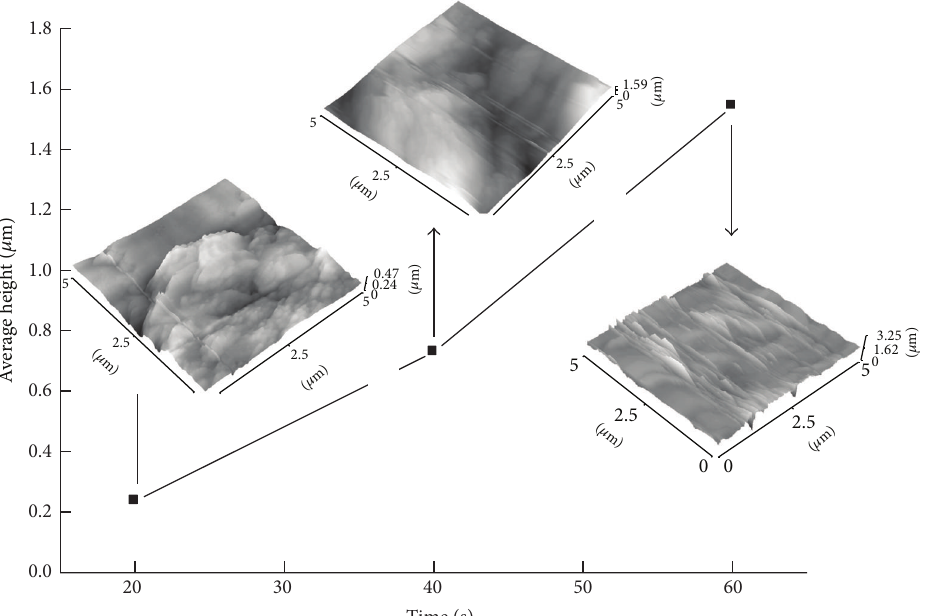
Figure 8: Average height measure by AFM for thin films deposited under potential − 1350mV with different time and its relative surface morphology of AFM